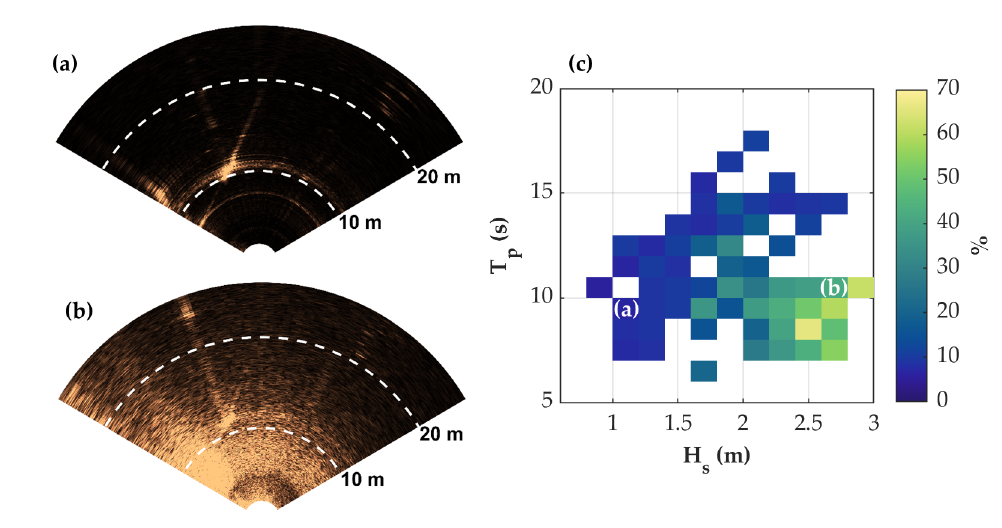
Figure 10. Kongsberg M3 multibeam sonar during WAMP deployment with ( a ) low and ( b ) high levels of bubble intrusion. ( c ) Average percentage of the sonar image (Kongsberg M3) that was obscured by bubbles as a function of the significant wave height ( H s ) and peak wave period ( T p ), based on an analysis of 147 sonar sequences. Sea states for ( a ) and ( b ) are annotated. The obstructed region was determined by applying a threshold to the image, and finding the region of the image above the threshold connected to the surface (e.g., left-hand side of ( a )). Morphological filters (dilation and fill) were then applied to reduce the effects of